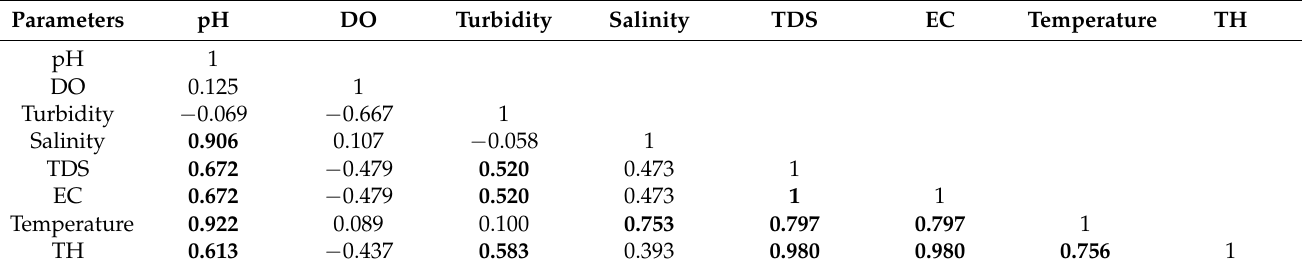
Figure 4. Principal component analysis of the analyzed heavy metal concentration by ( a ) scree plot and ( b ) component plot. Table 4. Pearson’s correlation matrix among the physicochemical parameters of leachate, surface water, and